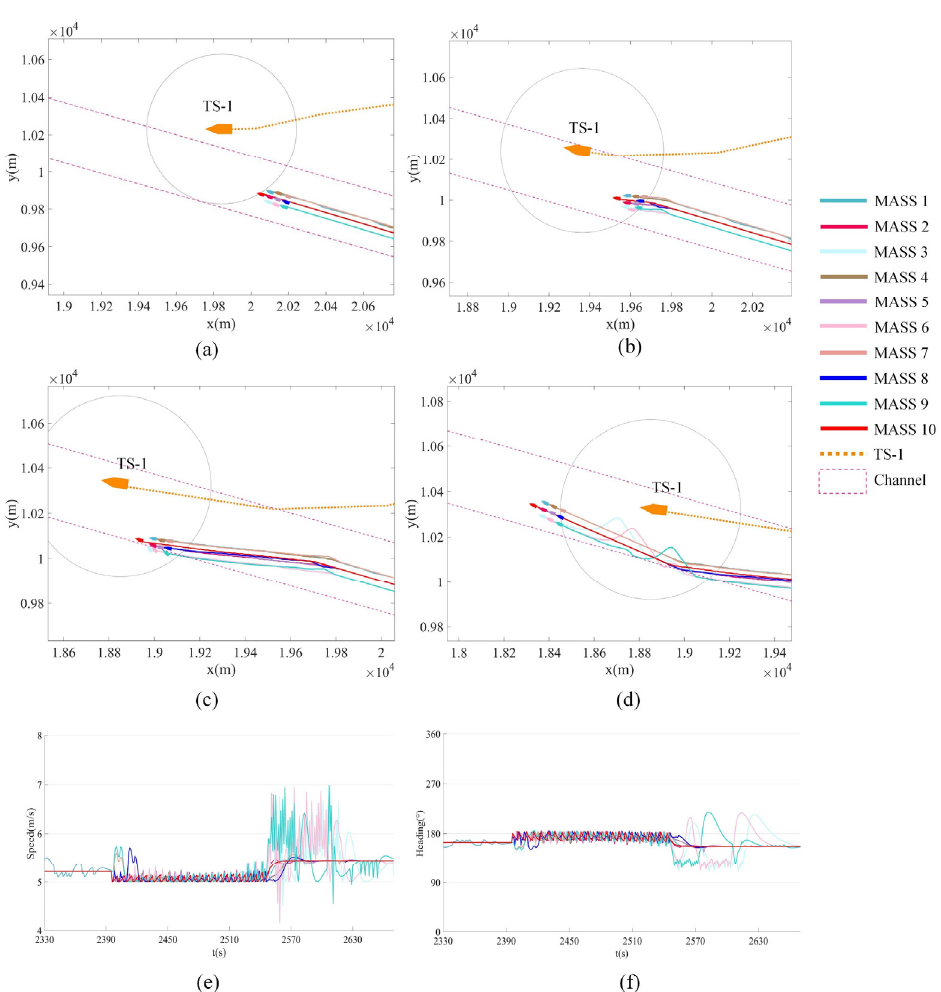
Figure 16. MASSs formation encountered one target ship situation. ( a ) About to form an encounter situation. ( b ) Gave way to TS-1. ( c ) Some MASSs went out of channel and returned to channel. ( d ) Avoidance completion of encounter situation to adjust formation pattern. ( e ) The MASS speed change during the situation. ( f ) The MASS heading change during the situation.